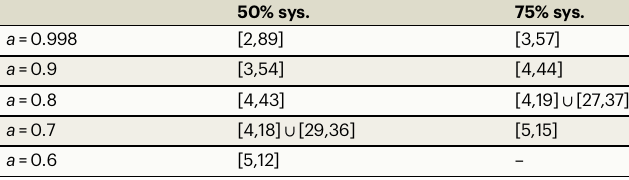
Table 2 | Projected exclusion ranges of spin-1 ULB masses 50% sys. 75% sys.